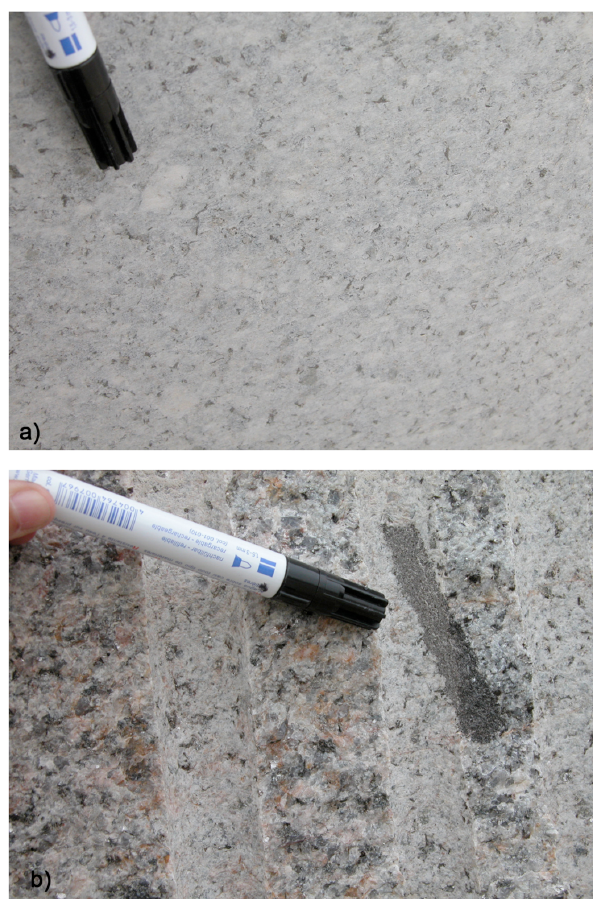
Fig. 2. Mesoscopic aspect of the bluish granites, exhibiting scarce feldspar phenocrysts, (a) , and rare micaceous enclaves, (b) .